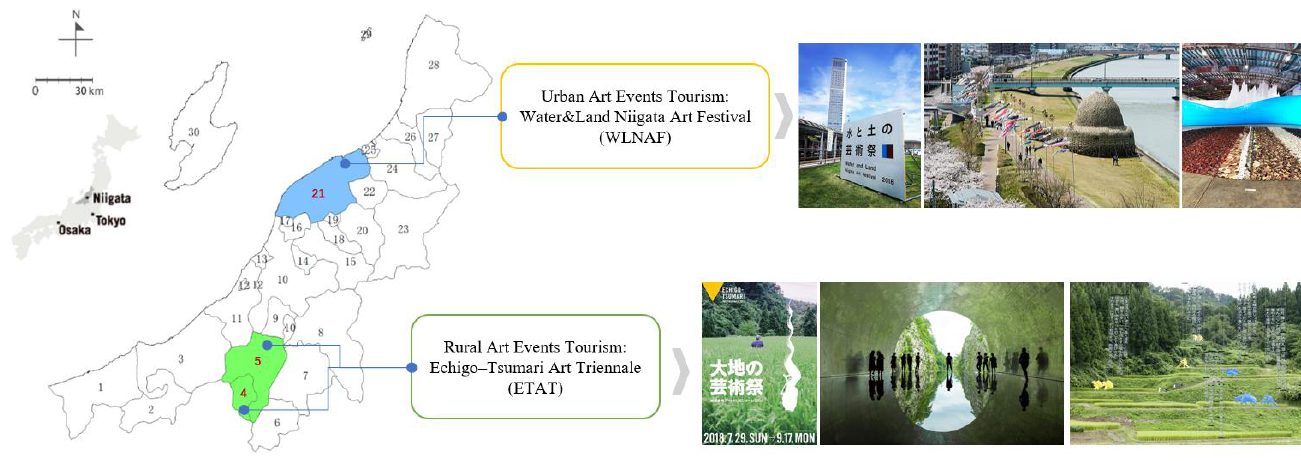
Figure 2. Spatial 30 cities in the Niigata area.